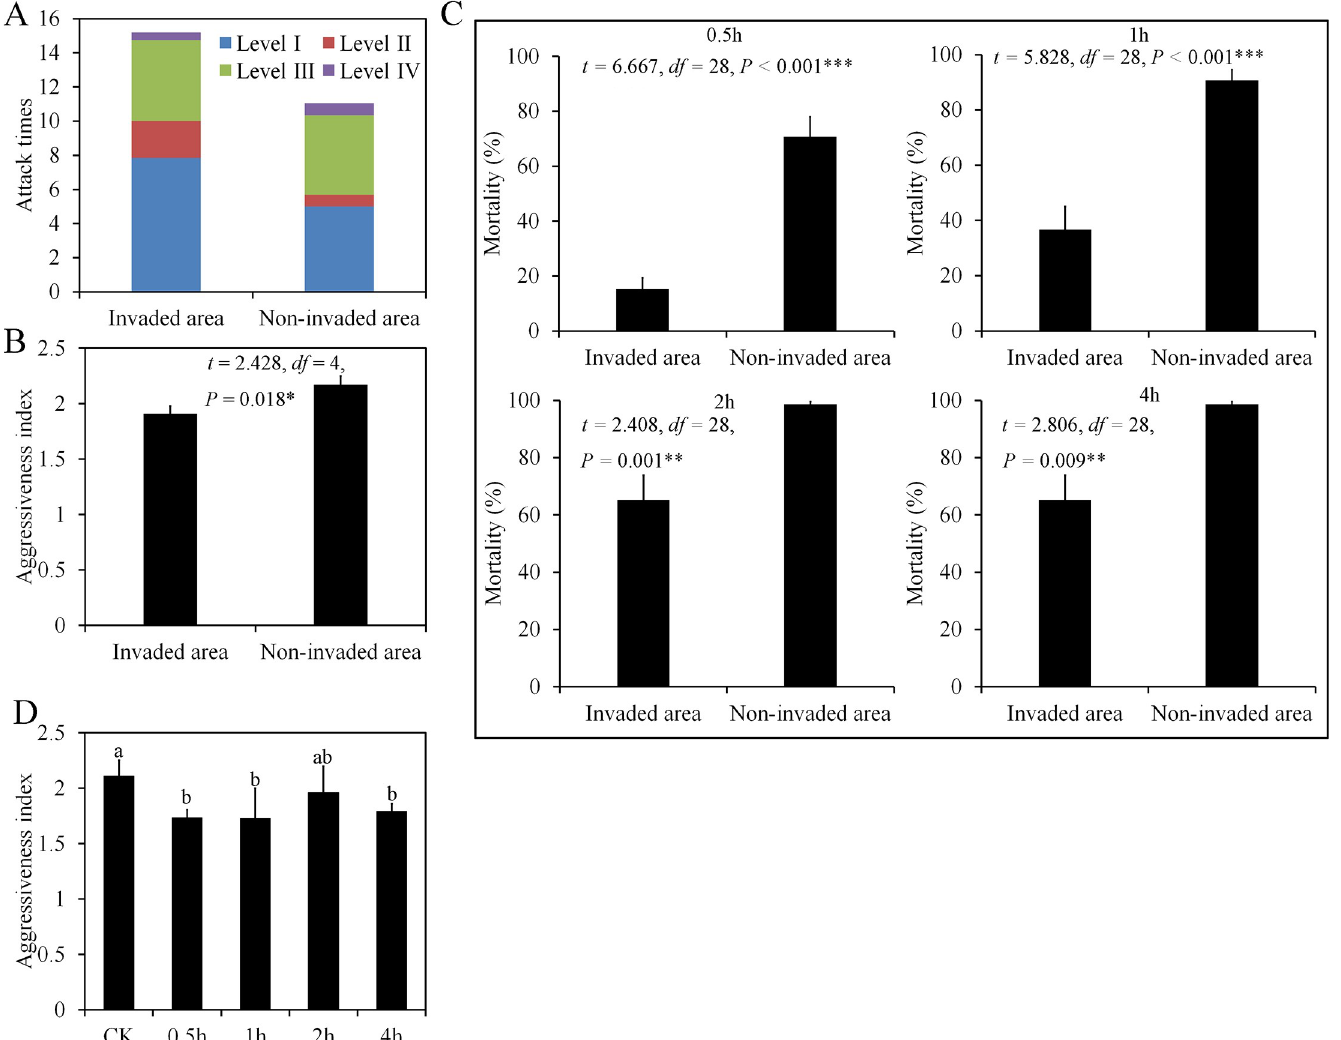
Fig 2. Individual and group behavior of workers of T . melanocephalum from either invaded or non-invaded areas when attacked by S . invicta workers. (A) Attack level (No significant difference of attack levels was found between invaded and non-invaded areas except Level II; Level III: t = 0.044, df = 2, P = 0.178; Level II: t = 4.612, df = 2, P = 0.044; Level III: t = 0.143, df = 2, P = 0.899; Level IV: t = -1.0, df = 2, P = 0.423) and (B) aggressiveness index (Independent sample t test, mean ± SE, n = 3 biological replicates) between S . invicta and T . melanocephalum from S . invicta invaded and non-invaded areas. (C) Group mortality